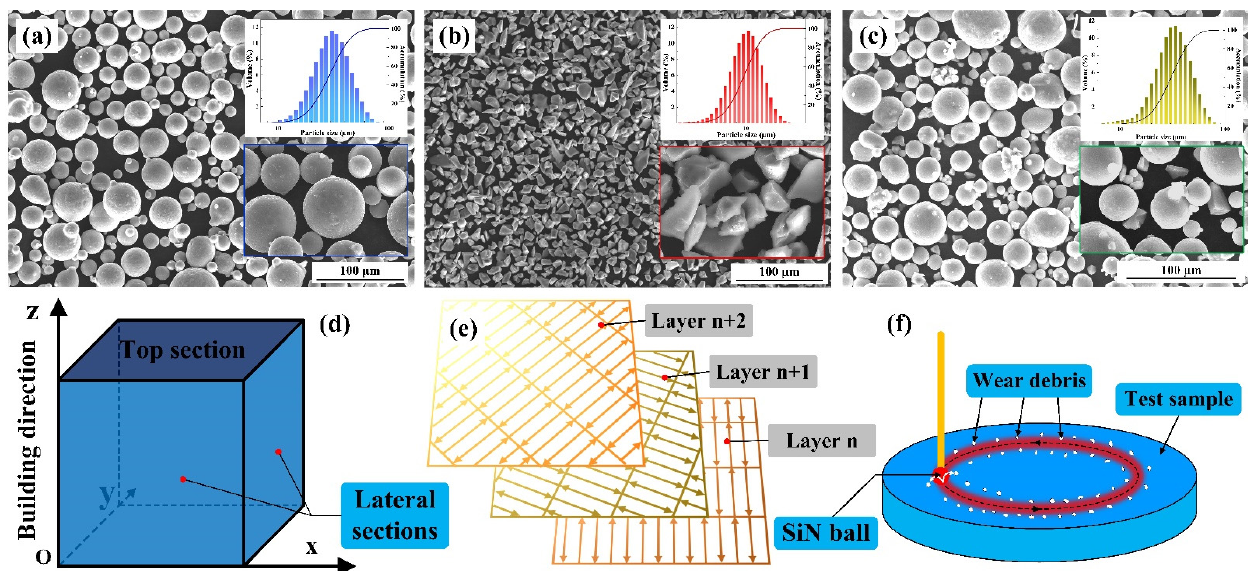
Figure 1. Surface morphologies of ( a ) Al-Zn-Mg-Cu alloy powders, ( b ) SiC powders, and ( c ) 4 wt.% SiC/Al-Zn-Mg-Cu composite powders with insert showing the particle size distribution histogram. Schematics of ( d ) sample orientation, ( e ) laser scanning strategy, and ( f ) friction and wear test. Table 1. Sample labels of as-printed Al-Zn-Mg-Cu alloy and SiC/Al-Zn-Mg-Cu composites.